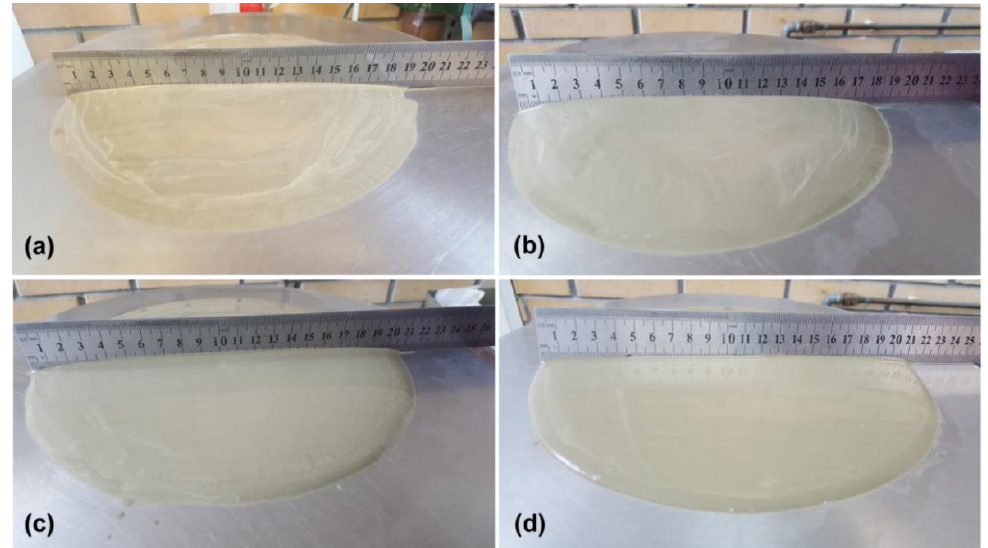
Figure 6. Digital photos of the slump for the reference sample ( a ) and the mixture containing 1 wt.% admixture of silica ( b ), silica-lignin hybrid material 1:5 wt./wt. ( c ) and lignin ( d ).